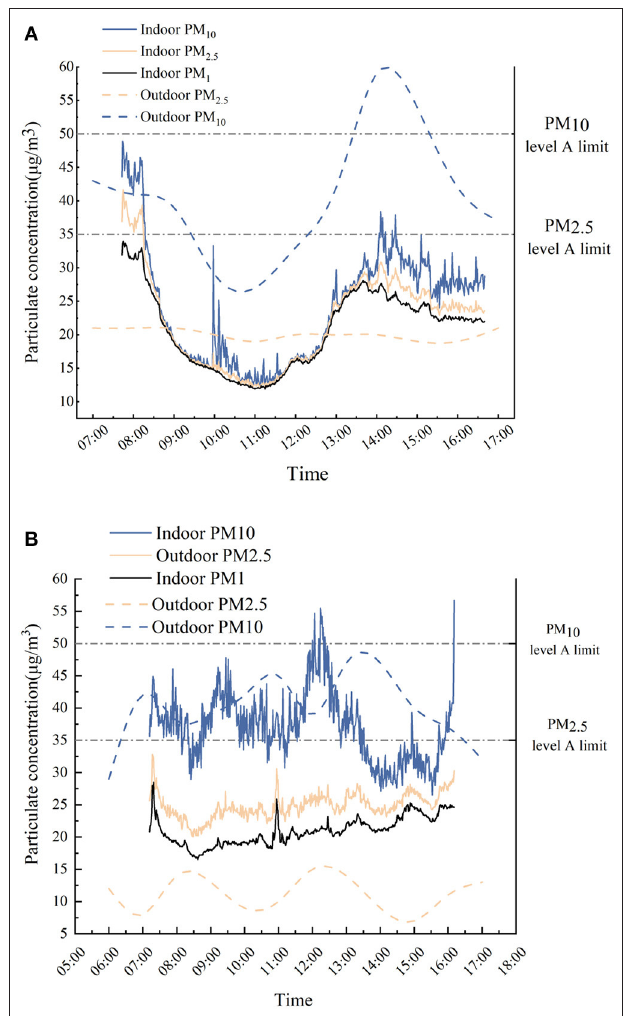
FIGURE 4 | Hourly variation of PM 1 -PM 2.5 -PM 10 inside and outside of the library (A) and canteen (B) based on the 5S-TPS